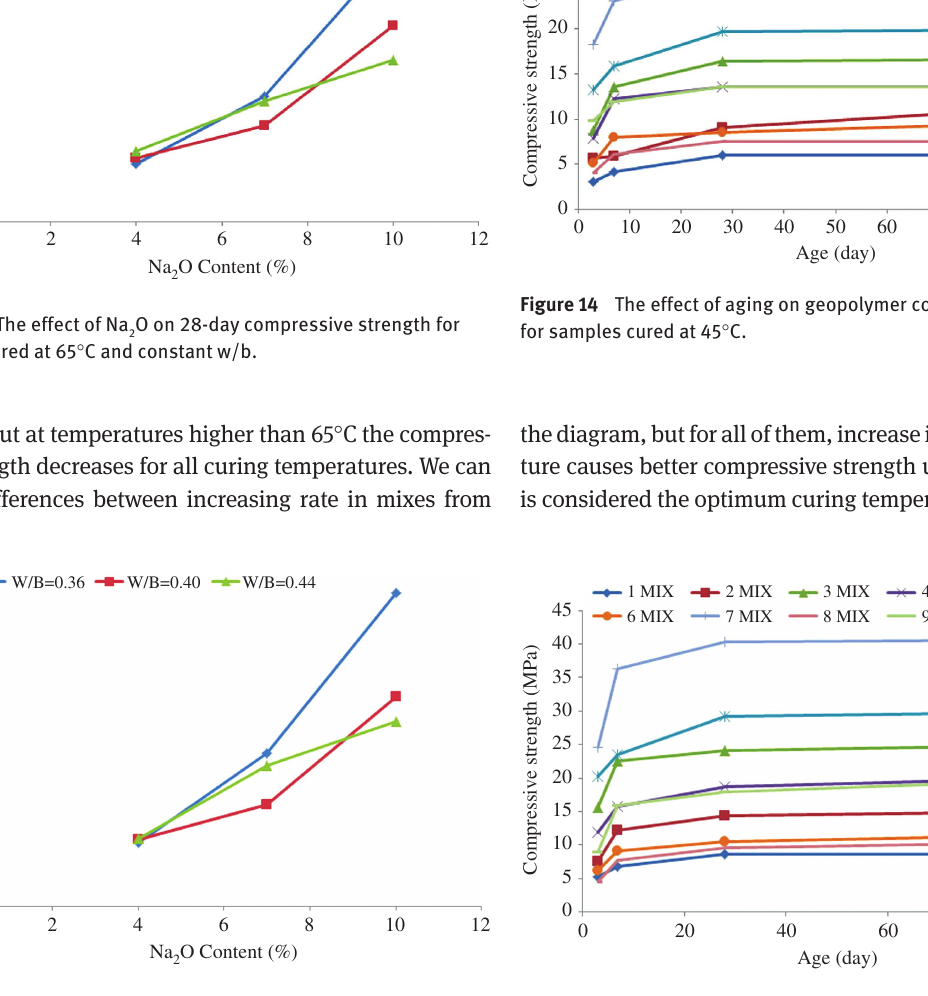
Figure 15 The effect of aging on geopolymer compressive strength for samples cured at 65 °